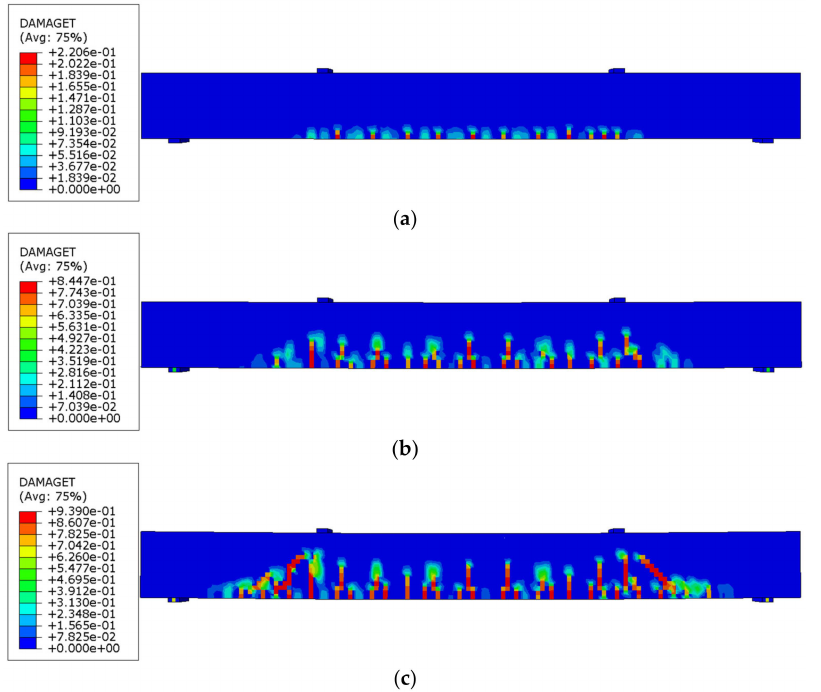
Figure 12. Visualization of the development of cracks in Beam 3 under increasing displacements: ( a ) 1.34 mm, ( b ) 5.53 mm, and ( c ) 10.22